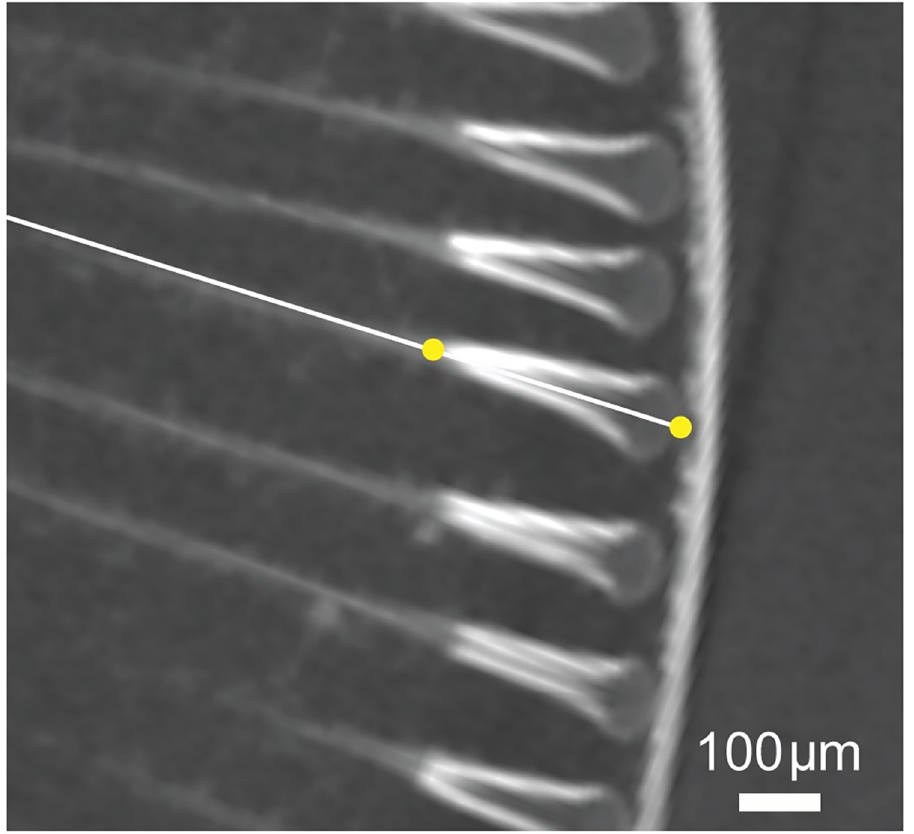
Fig 4. Micro-CT section image of the medial eye of P . sedentaria showing the distal crystalline cone abutting the long light guide proximally. The two marked points, one central on the cornea and the other at the junction between the crystalline cone and the light guide, determine the optical axis of the